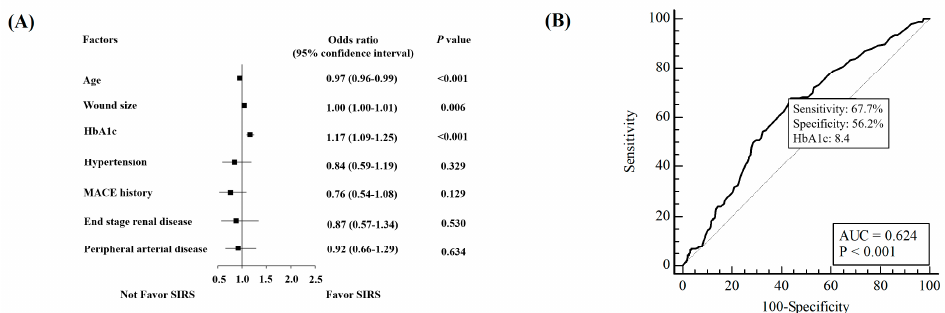
Figure 2. Treatment outcome results and associated factors for severe DFI patients with SIRS. ( A ) The prognosis of patients with grade 3 DFI and those with SIRS. Patients with SIRS had higher major lower-extremity amputation (LEA) ( p = 0.001) and relatively higher in-hospital mortality ( p = 0.08); ( B ) The presentation of individual component of SIRS did not affect the prognosis.